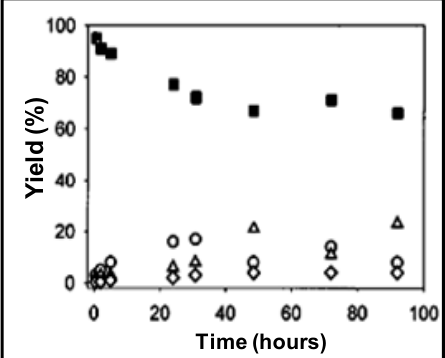
Figure 12. Molar yield of phenol ( ) alkylation with tert -butanol to the products 2- tert - butylphenol ( ○ ), 4- tert -butylphenol ( Δ ), and 2,4-di- tert -butylphenol ( ◊ ) at 275 °C